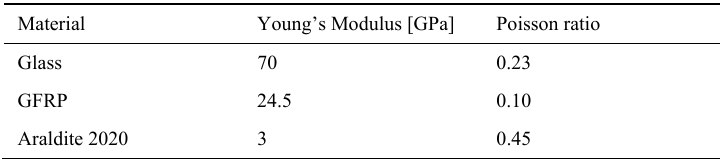
Table 1: Mechanical properties of the